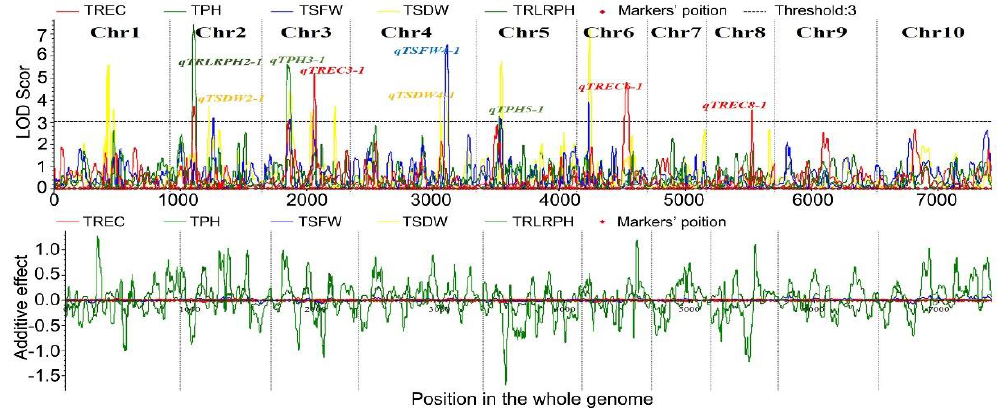
Figure 4. QTL mapping results of seedling-related traits in F 2:3 populations (2 ° C , 5 d). Note: PH, SFW, SDW, REC, and RL represent plant height, seedling fresh weight, seedling dry weight, relative electrical conductivity, and root length, respectively.